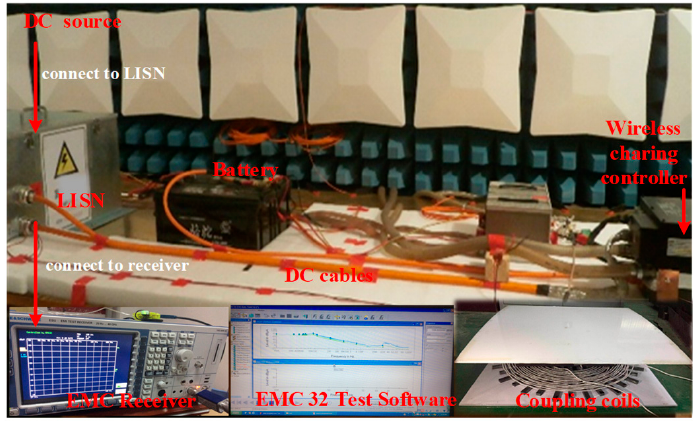
Figure 2. The test platform for conducted-EMI emission.